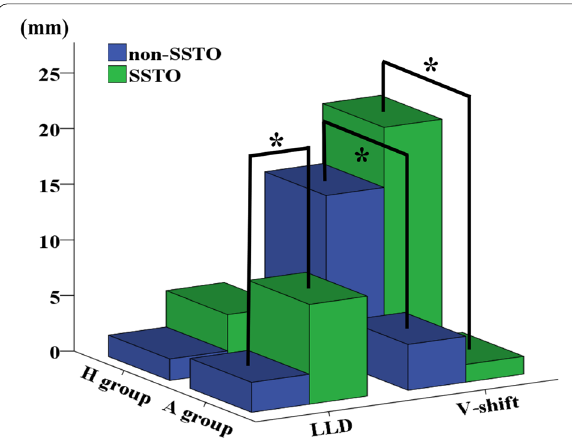
Fig. 3 Comparison of LLD and V-shift based on the presence and absence of SSTO in both groups. * p < 0.05